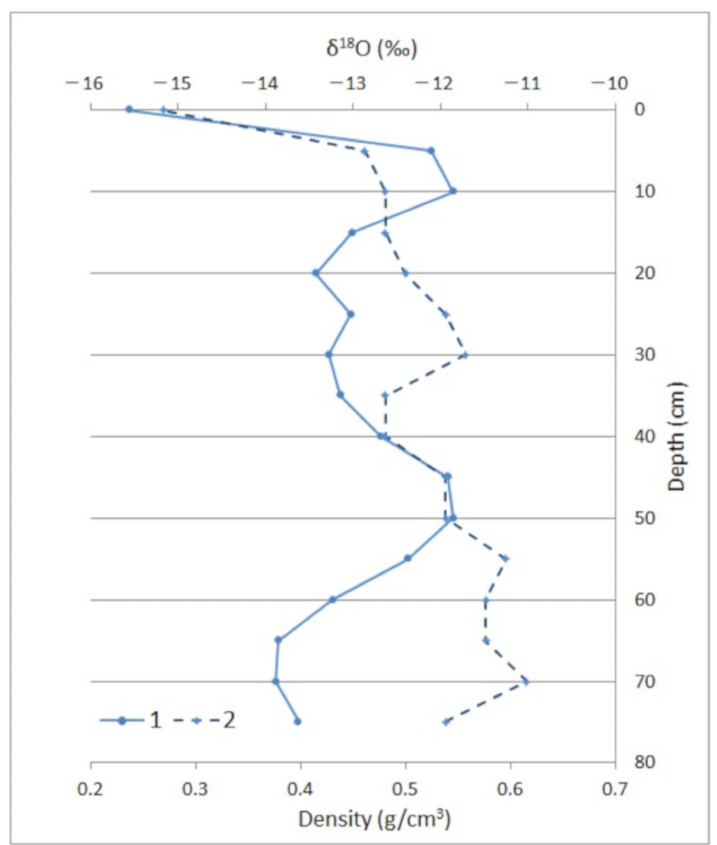
Figure 4. Isotopic composition of snow and firn on dome-shaped glacier No. 55. 1— δ 18 O, 2—Density.